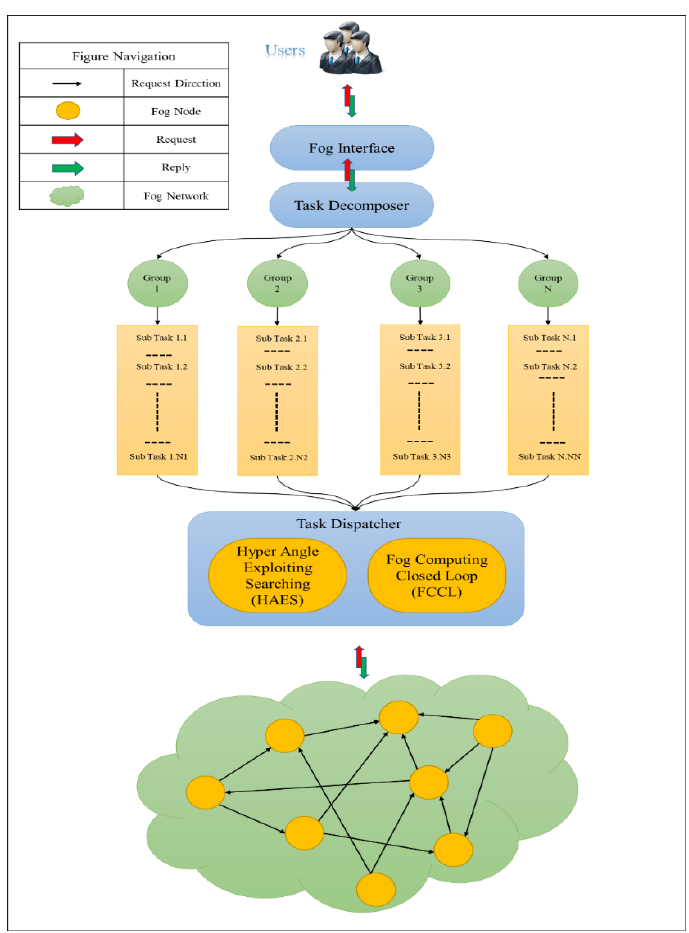
Figure 3. The framework of multi-criteria optimization for fog computing.